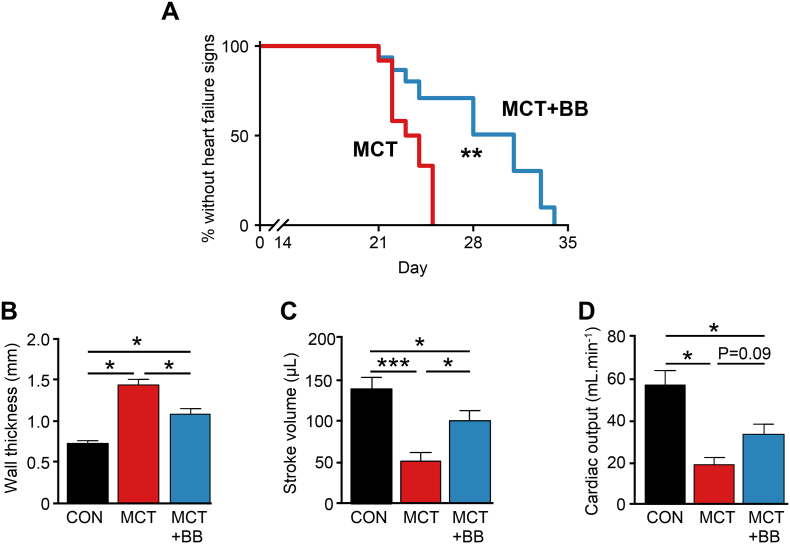
Metoprolol delayed the onset of heart failure in rats with pre-existing PAH. A The median day to failure signs was increased from 23 to 31 days post MCT injection (N = 12 MCT, 15 MCT + BB rats, ** P < .01, Mantel-Cox test). Echocardiography measurements of RV function were performed on the day of heart failure signs (MCT) or the median survival day of MCT rats (CON and MCT + BB). B RV wall thickness was reduced in MCT + BB rats compared to MCT, indicating attenuation of hypertrophy. C Stroke volume was increased by BB D Cardiac output was not significantly increased with BB (P = .09 vs MCT). B-DN = 9 CON, 7 MCT, 5 MCT + BB rats. One-way ANOVA. * P < .05, *** P < .001.